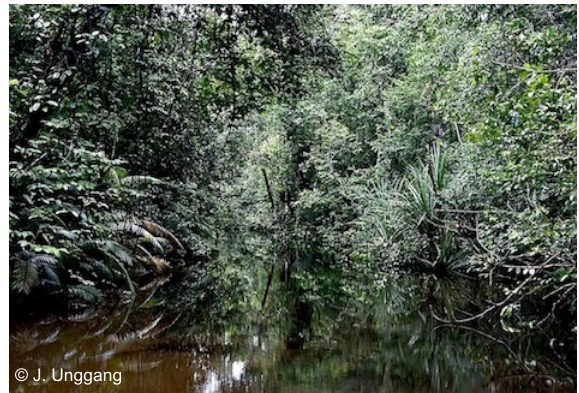
© R.A. Image 6. A section of flooded forest by the Sg. Penyilam